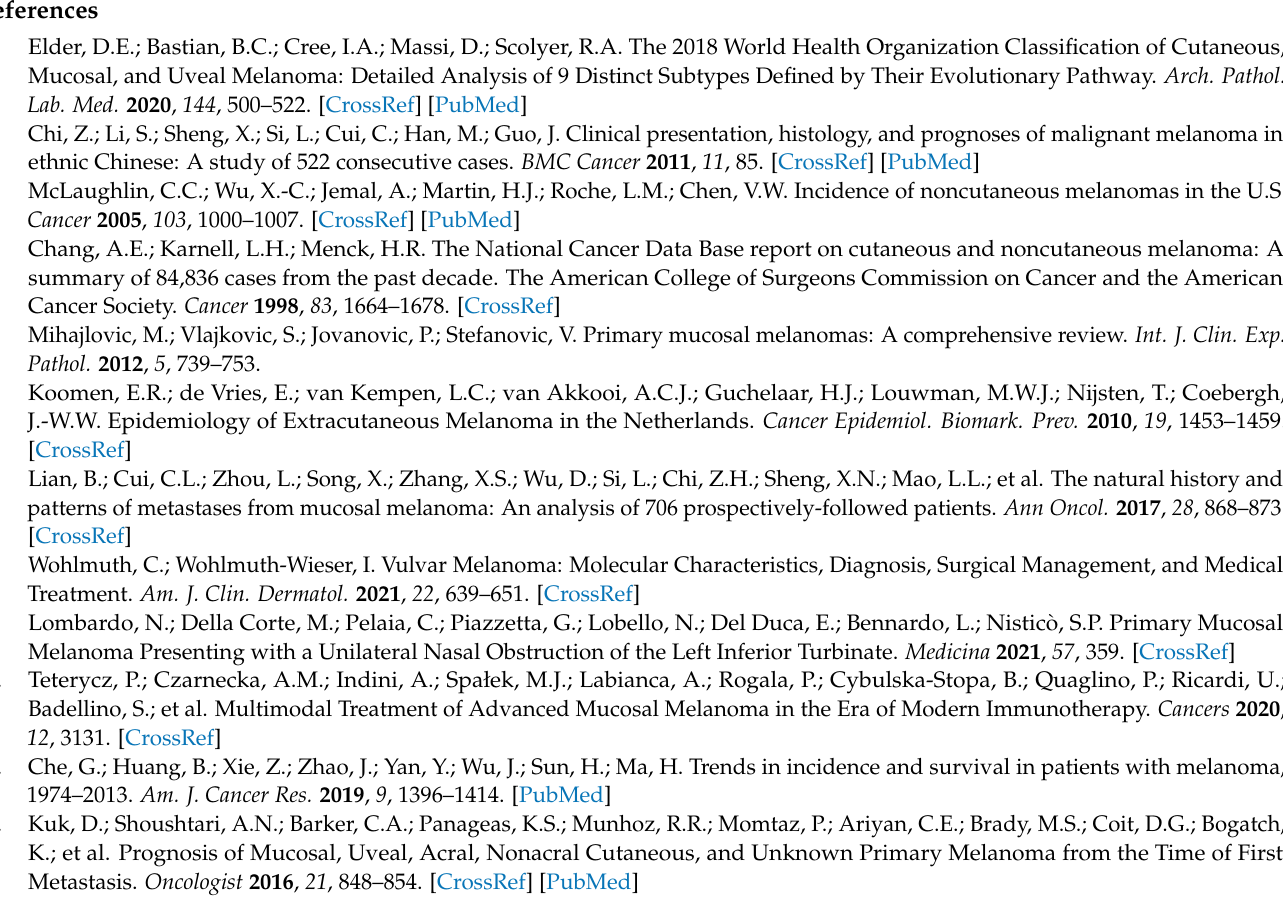
Table S2. Primary treatment of mucosal melanoma by stage of